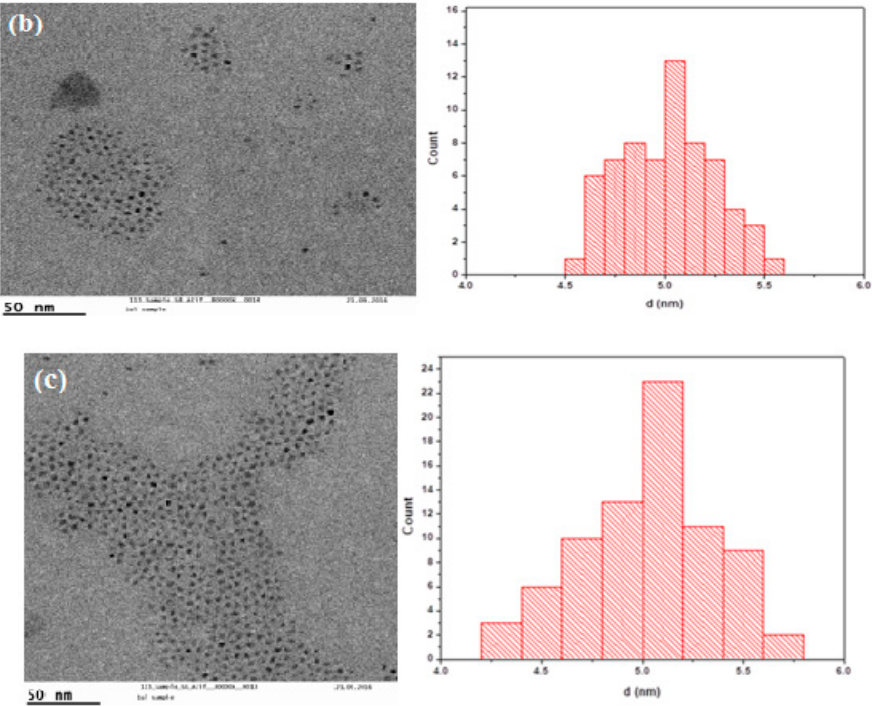
Figure 3. TEM analysis of doped CdS/ZnS quantum dots for different concentrations of Cu precursor. ( a ) Cu precursor of 0.78 µM, the an average diameter of the NPs was 4.99 nm with σ = 0.3 nm; ( b ) Cu precursor of 1.56 micro molar, the average diameter of the NPs was 5.01 nm with σ = 0.26; ( c ) Cu precursor of 3.12 micro molar, the average diameter of the NPs was 5.01 nm with σ = 0.33 nm. Nanomaterials 2022 , 12 , x FOR PEER REVIEW